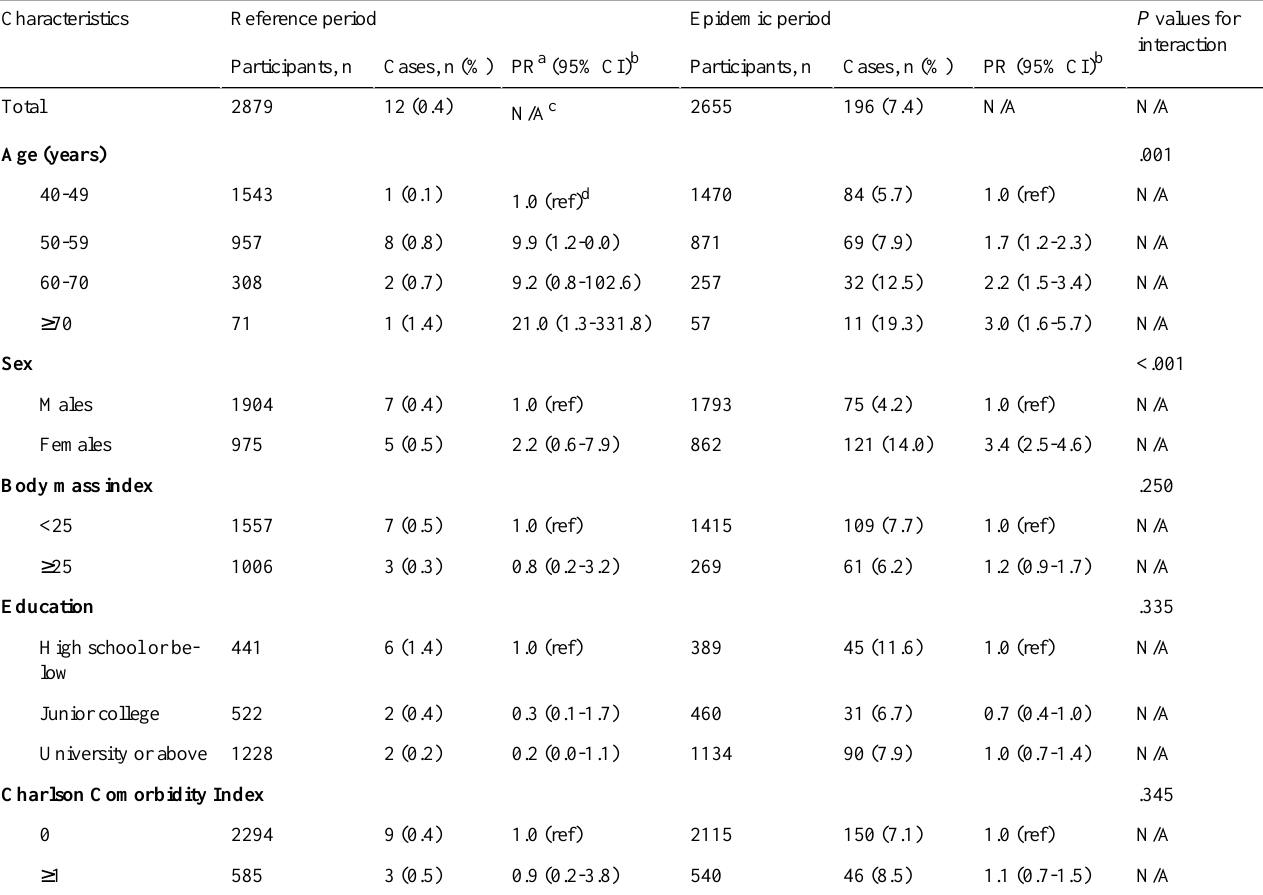
Table 4. Association of prevalence of frequent low daily steps cases ( ≤ 1500 steps/day for ≥ 14 days) and basic characteristics.